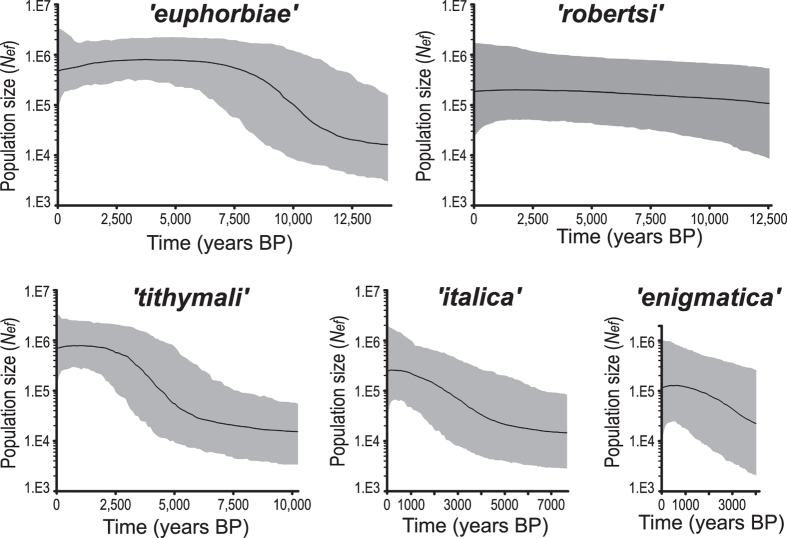
Bayesian skyline plots (BSPs) showing past population size dynamics for mitochondrial haplogroups.The black line indicates the median estimate of effective female population size Nef through time, the grey area reflects the 95% highest posterior density (HPD) limits. BSPs for ‘melitensis’ and ‘cretica’ are uninformative due to a very short time to coalescence (>1,000 years BP) and are thus not shown.